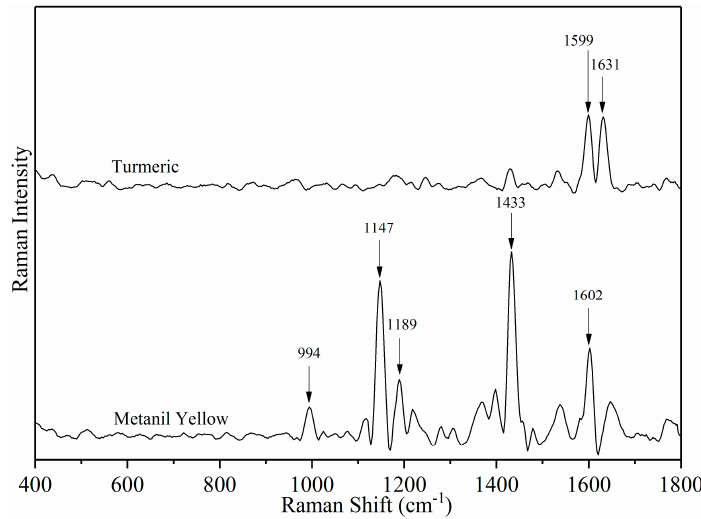
Figure 4. Raman spectra of turmeric and metanil yellow.